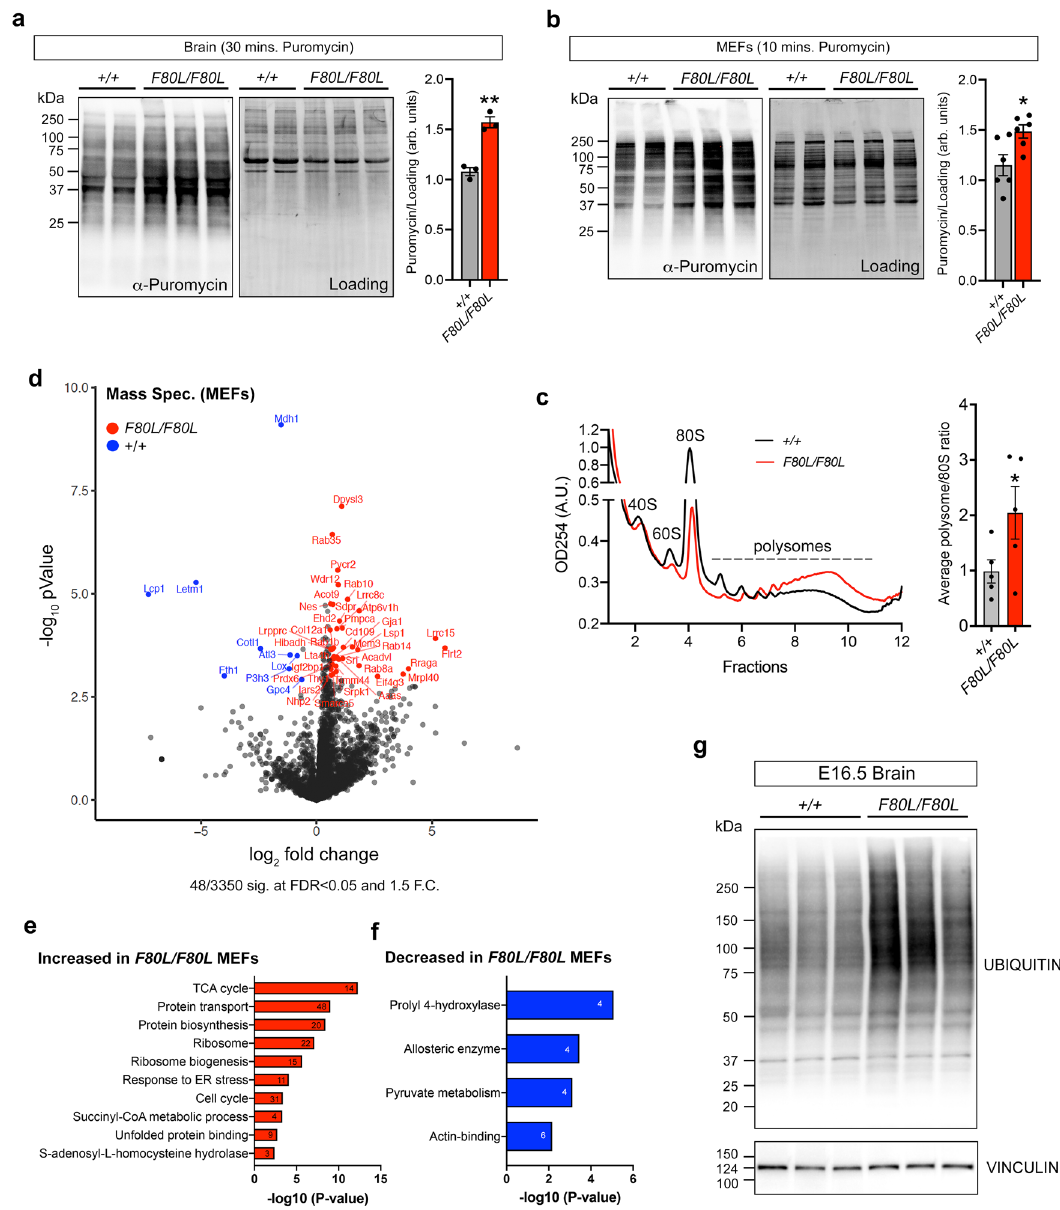
Fig. 7 Ronin F80L/F80L mice have defects in ribosome biogenesis leading to deregulated translation. a , b Western blot analysis of puromycin incorporation assays. Data are shown as mean ± SEM, n = 3 (MEFs) or 6 (brains) wild type, n = 3 (MEFs) or 6 (brains) mutants, statistically signi fi cant differences between genotypes were determined using the t test (two-tailed). ** p = 0.002, * p = 0.02. c Polysome pro fi ling of wild type and Ronin F80L/F80L E18.5 brains. Data are shown as mean ± SEM, n = 5 wild type, n = 5 mutants, statistically signi fi cant differences between genotypes were determined using the t test (two-tailed). * p = 0.047. d Volcano plot of the Ronin F80L/F80L MEF protein mass spectrometry. e , f GO analysis of the proteins upregulated and downregulated in the Ronin F80L/F80L MEF mass spectrometry. g Western blot of increased protein ubiquitination in E16.5 Ronin F80L/F80L brains. Source data are provided as a Source data fi